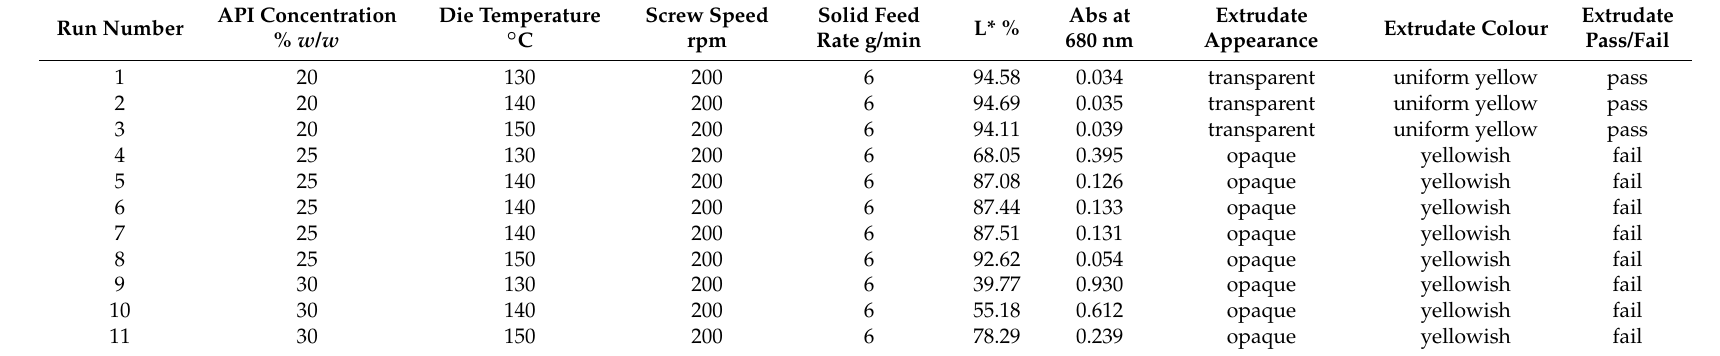
Table 4. Parameters and responses for DoE2, central composite